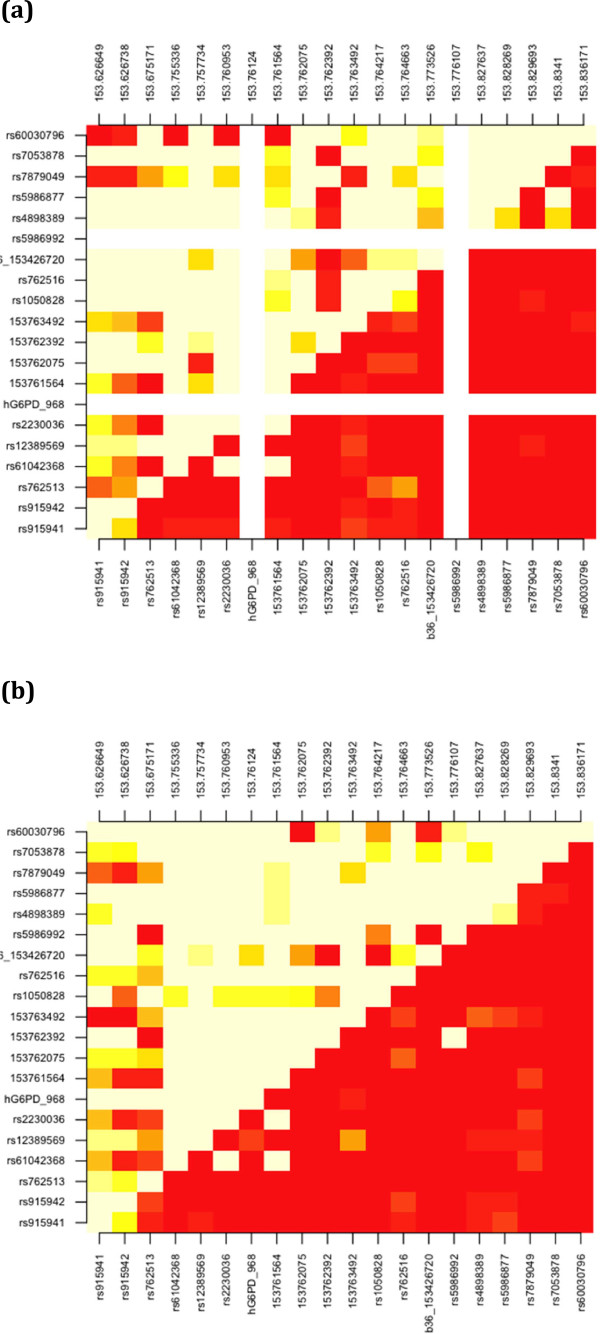
Pairwise linkage disequilibrium. (Top left D’, Bottom right R-square; red = 0 - > cream = 1). (a) Dogon, (b) Fulani. White lines refer to SNPs that are monomorphic.